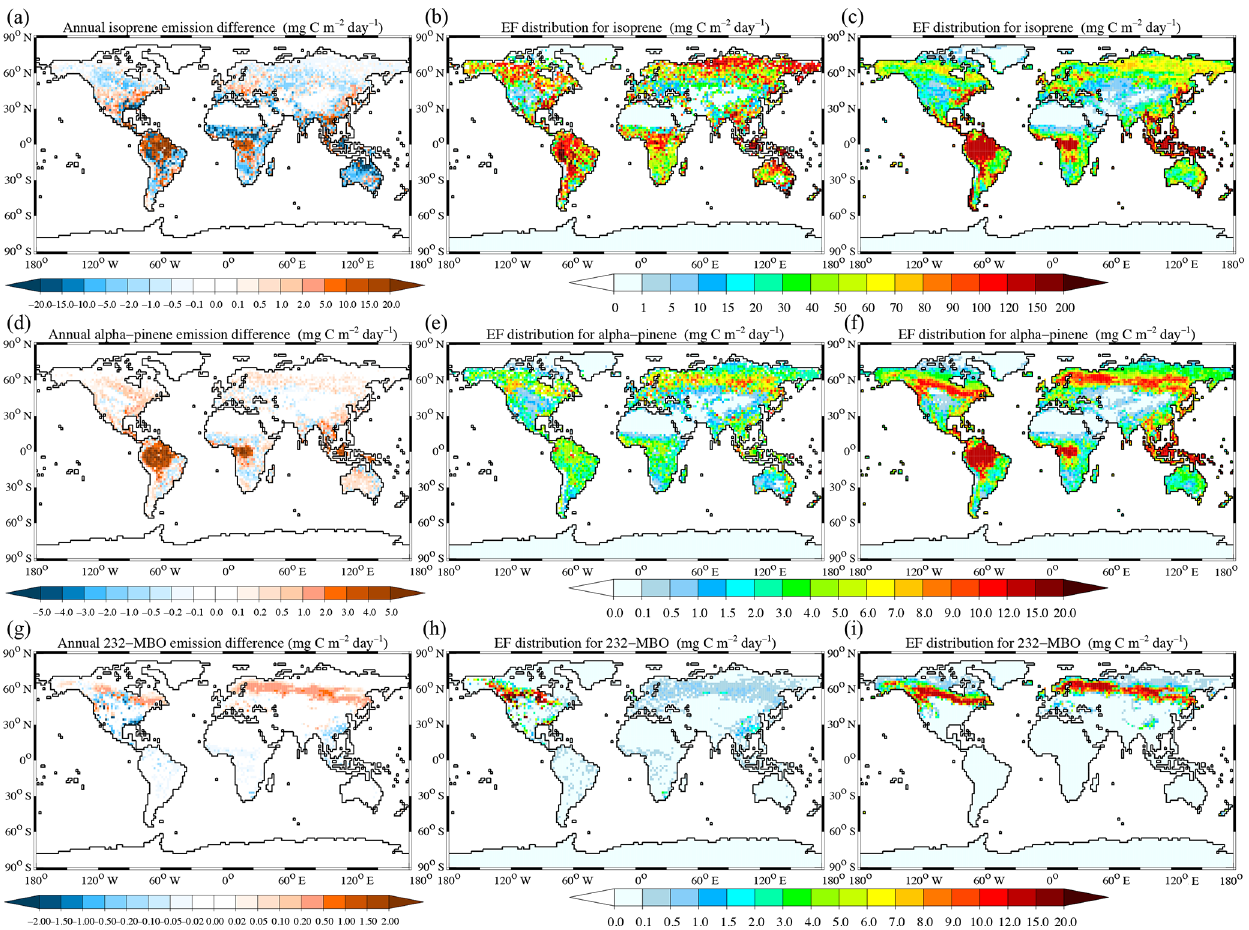
Figure 6. (a) Difference in isoprene annual emissions (mgCm − 2 day − 1 ) between the PFT-CLM4 and reference simulations; (b) spa- tial distribution of emission factors (mgCm − 2 day − 1 ) derived from global maps for isoprene, (c) spatial distribution of emission factors (mgCm − 2 day − 1 ) derived from MEGAN-CLM4 PFT distributions for isoprene; (d–f) same as panels (a–c) for α -pinene; (g–i) same as panels (a–c) for